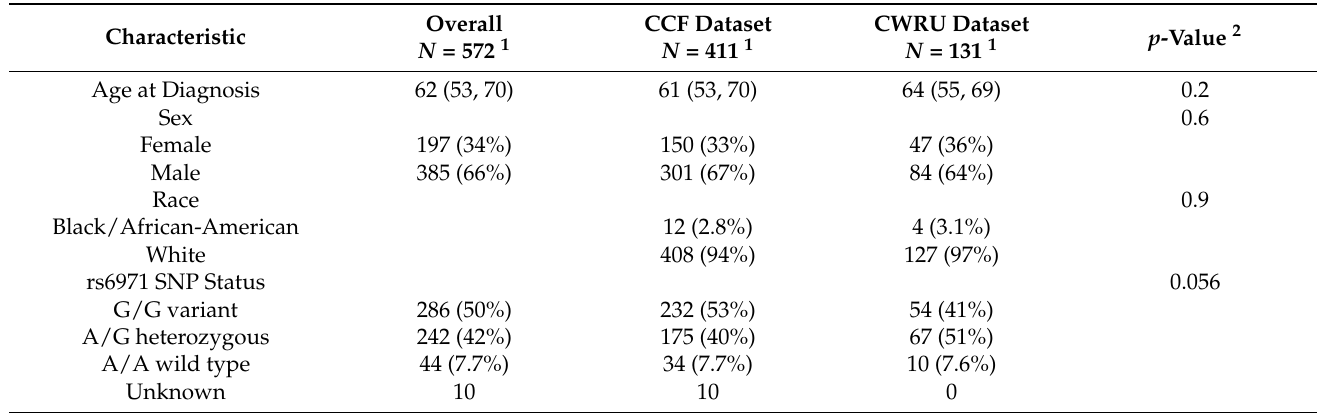
Table 3. Comparison between CCF and CWRU datasets for TSPO rs6971